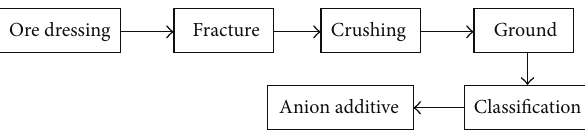
Figure 4: Negative ion additive preparation